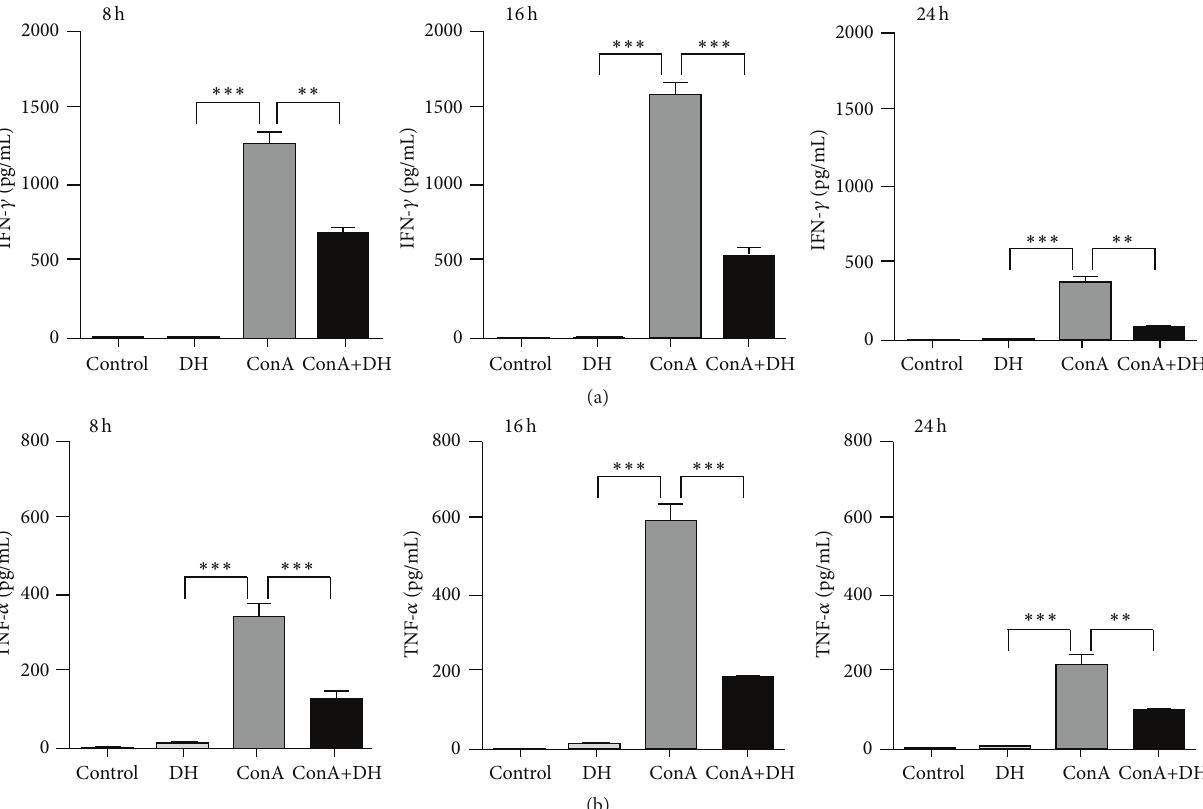
Figure 5: DH inhibits expression of IFN- 𝛾 and TNF- 𝛼 in ConA-induced hepatitis. Notes: blood samples were collected from Control, DH- treated, ConA, and ConA+DH groups at 8, 16, and 24 hours after ConA injection. Serum levels of IFN- 𝛾 (a) and TNF- 𝛼 (b) were detected by ELISA. Data is expressed as mean ± SD ( 𝑛 = 5 ; ∗∗ 𝑃 < 0.01 and ∗∗∗ 𝑃 < 0.001 ). ConA: Concanavalin A; DH: Dracocephalum heterophyllum ; IFN- 𝛾 : interferon- 𝛾 ; TNF- 𝛼 : tumor necrosis factor; ELISA: enzyme-linked immunosorbent